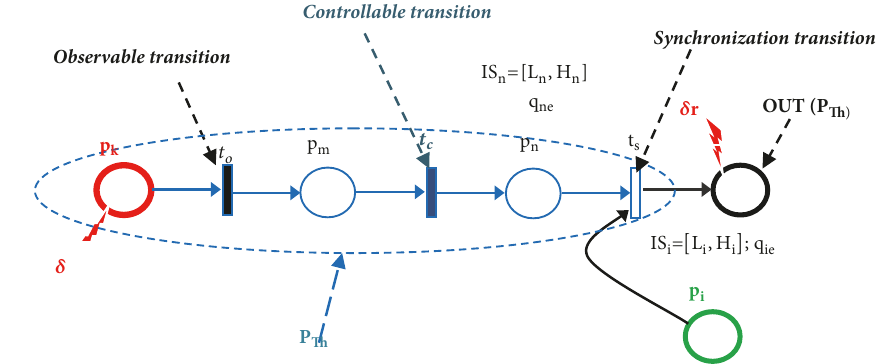
Figure 10: Example of disturbance propagation: Approach 1.